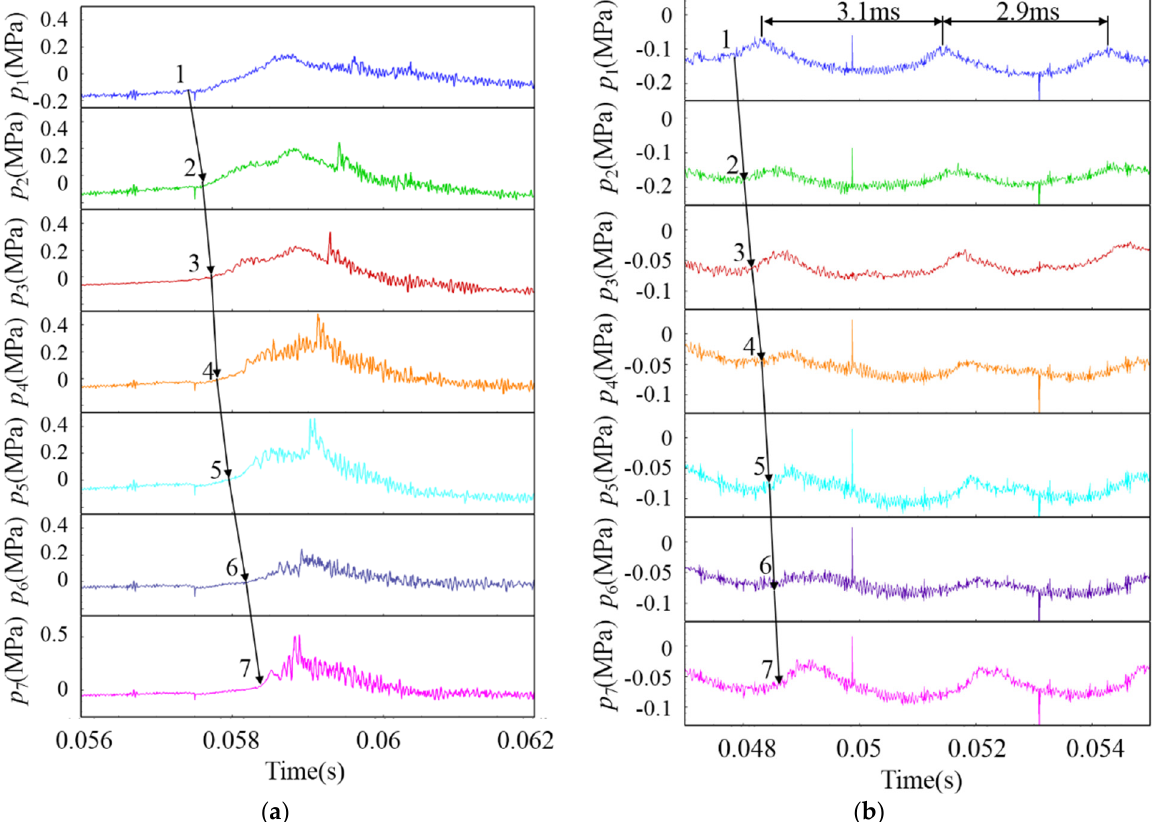
Figure 10. Enlarged pressure waveform caused by self-ignition in Figure 9. ( a ) Enlarged view of Figure 9a. ( b ) Enlarged view of Figure 9b.